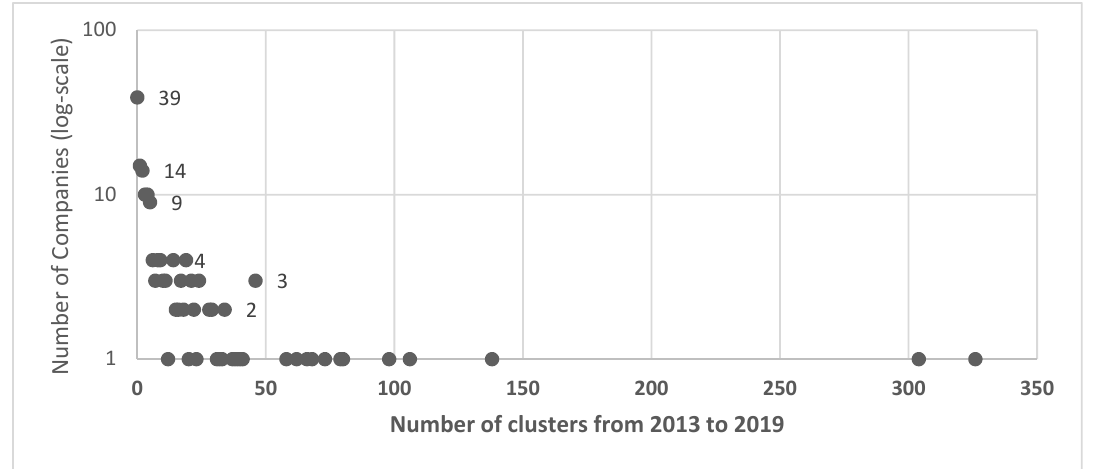
Figure 5. Distribution of number of clusters by Transmission Owner (TO) for 7 years (2013–2019).